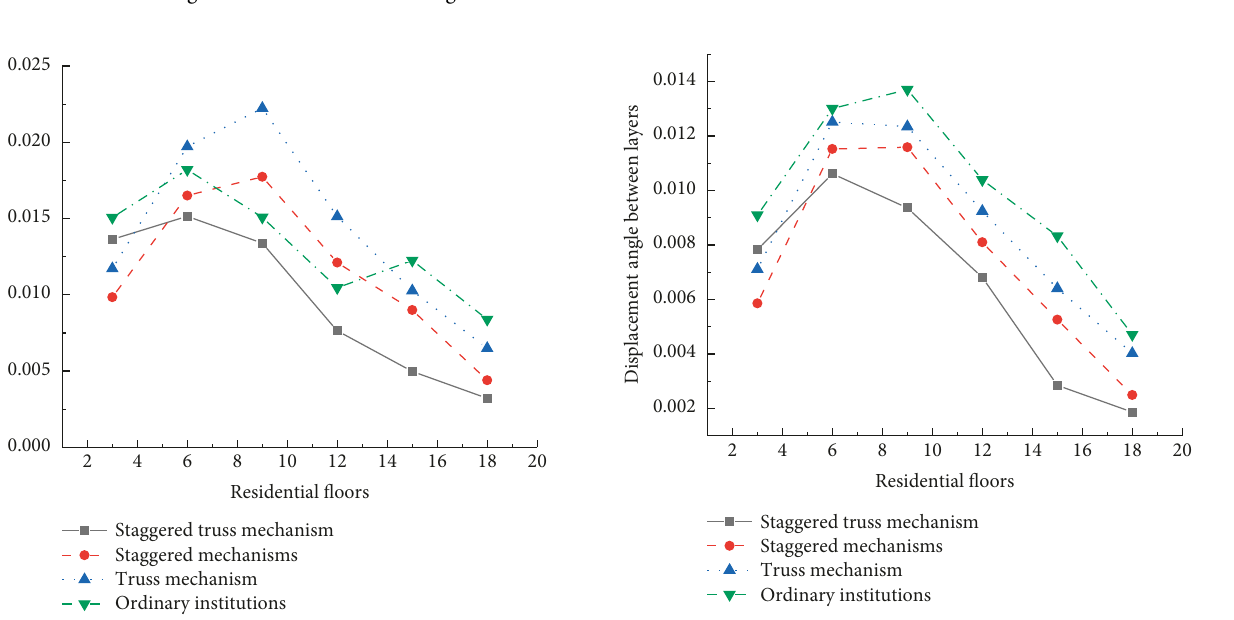
Figure 3: Relationship between shear stress and time under different accelerations. (a) The shear stress change at an acceleration of 50gal; (b) the shear stress change at an acceleration of 100gal.